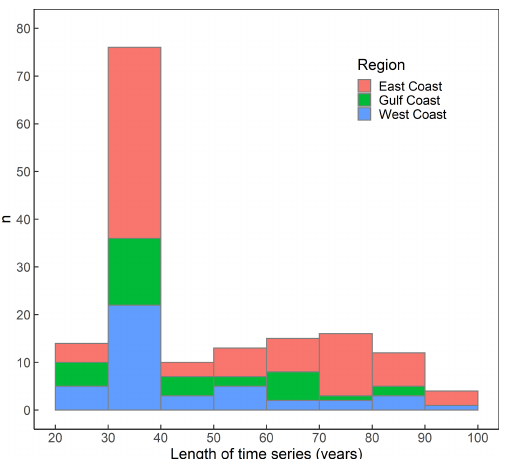
Figure 2. Histogram showing the length of overlapping time series in years (on the x axis) and the corresponding frequency n (on the y axis) for the observational data used in the analysis (lengths of model data sets are outlined in the text and the same for all loca- tions for a given variable). Note that we analyse 35 locations and a maximum of six driver combinations (from four drivers) at each location, all of which were used to derive the histogram. Bars are separated into East Coast, Gulf Coast, and West Coast